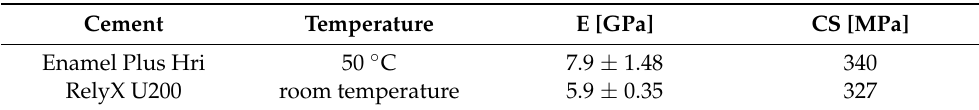
Table 3. Flexibility module E [GPa] and average compressive strength CS [MPa] of two studied cement before and after heating from